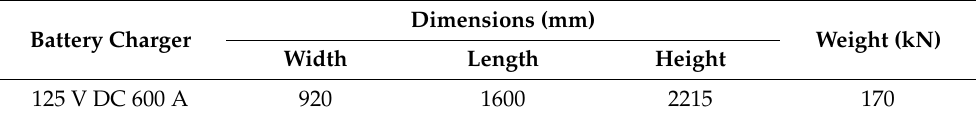
Table 1. Description of BC cabinet.